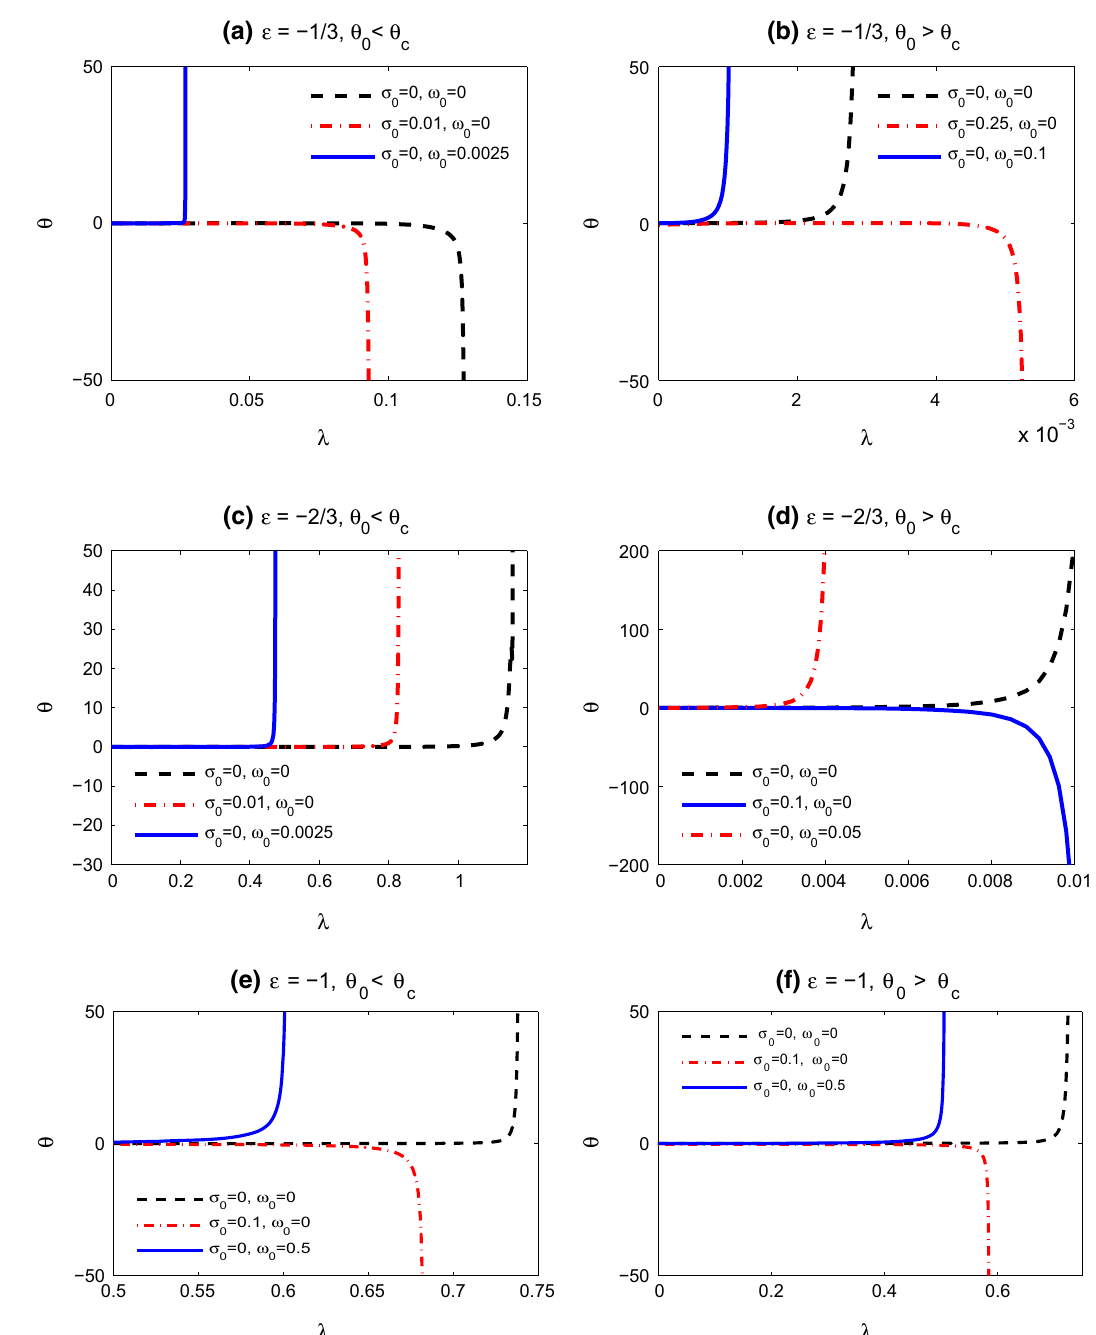
Fig. 6 The evolution of expansion scalar ( θ ) with the affine parameter ( λ ) for different values of the EOS parameter ( ε ) and initial conditions on ESR variables R μν u μ u ν > ω 2 ), there exist conjugate points and geodesic focussing/defocussing takes place accordingly. On the other hand, no finite time singularity exists for an initially non- contracting congruence (i.e., θ 0 ≥ 0) in the case that X is negative definite. For θ 0 < 0, there exists a critical value